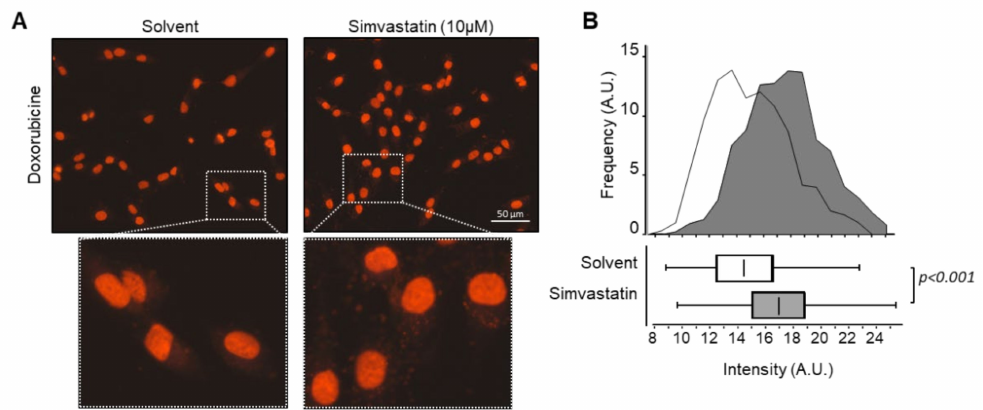
Figure 4. Simvastatin favors doxorubicin accumulation into osteosarcoma cells nuclei. ( A ) Intracellular uptake of dox- orubicin. Cells were exposed to doxorubicin (3.6 µ M) for 30 min in the presence or absence of simvastatin (10 µ M). The image was taken by fluorescent microscope equipped with a digital camera. Enlarged images are shown in the inserts. ( B ) Distribution of red fluorescent signal intensity as a function of the frequency of occurrence for vehicle-treated cells (light gray) and simvastatin-treated cells (dark gray). Results are also expressed as a box plot. Lower, middle, and top lines of boxes indicate lower quartile, median, and upper quartile, respectively. Whiskers indicate minima and